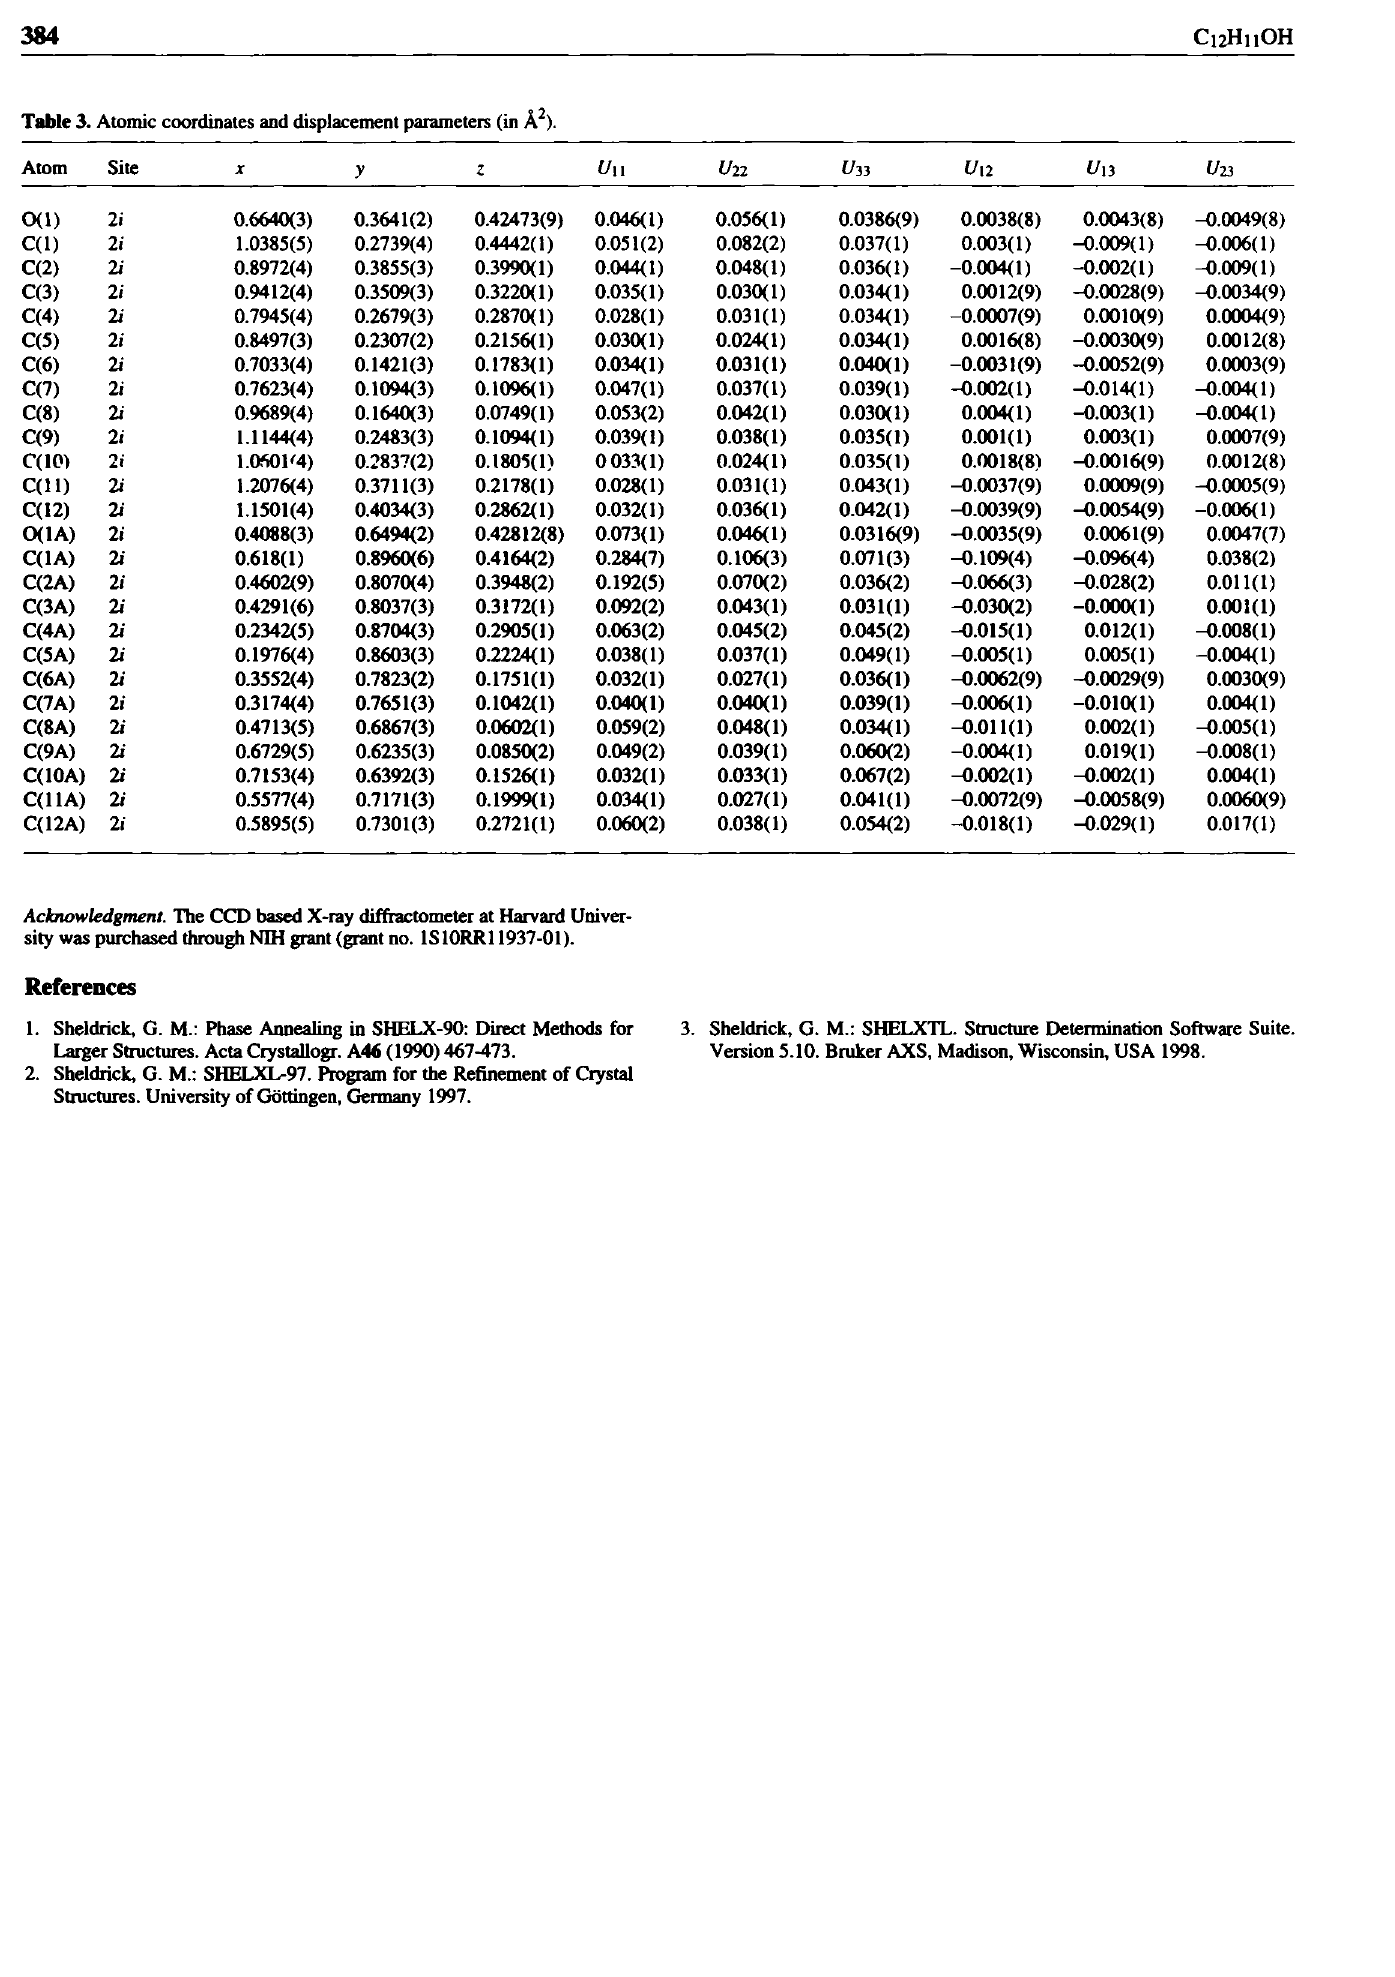
Table 3. Atomic coordinates and displacement parameters (in Ä 2